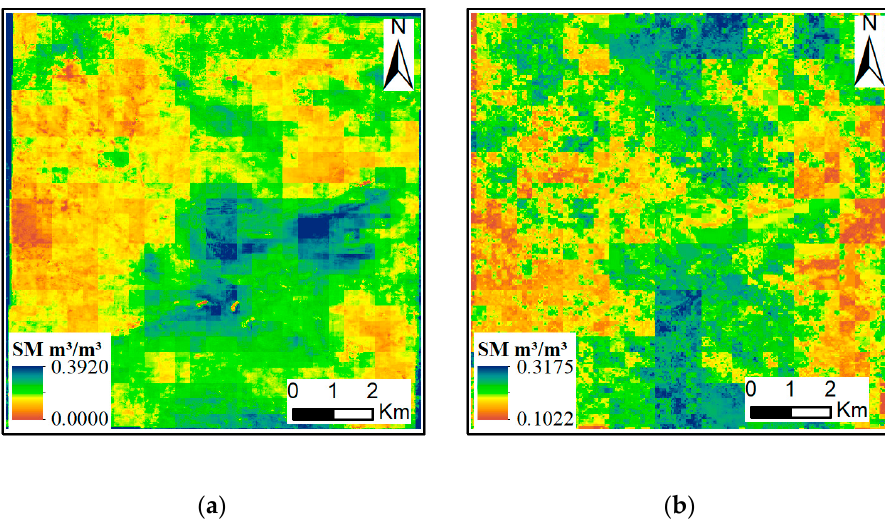
Figure 12. The downscaled SMs based on the ( a ) SM-RDNet and ( b ) RF